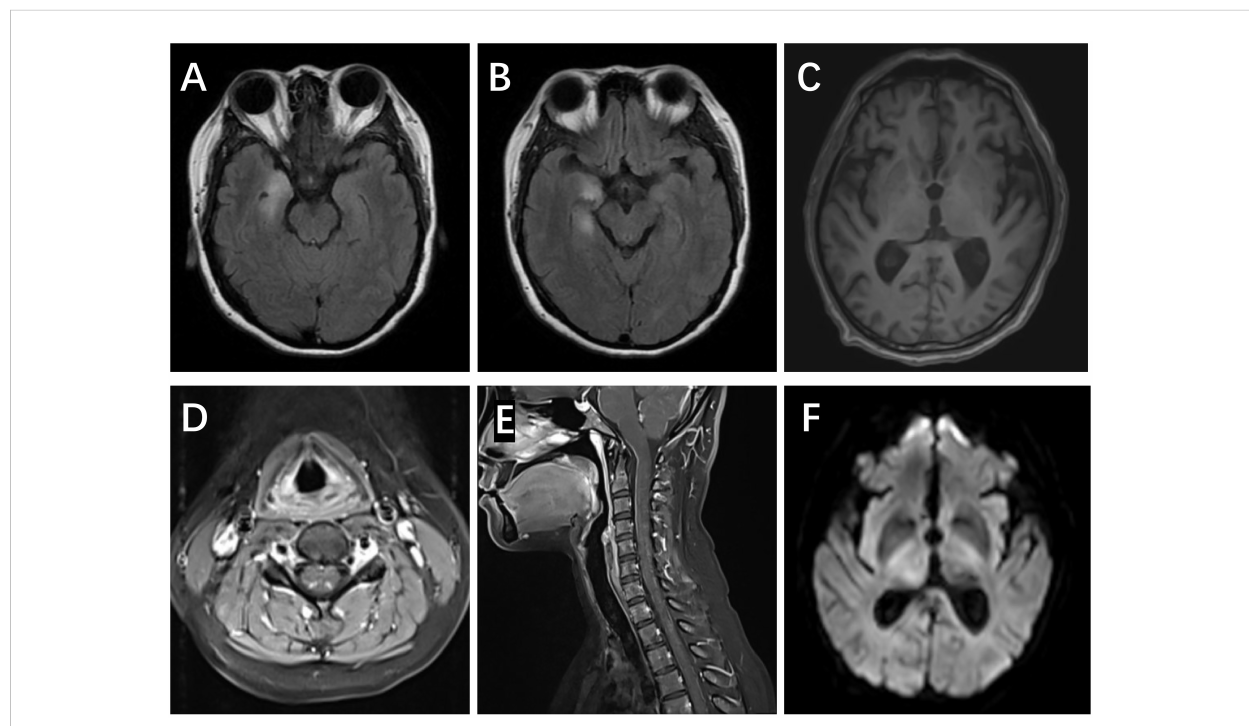
FIGURE 1 MRI scans in anti-amphiphysin encephalitis. (A, B) Right FLAIR hyperintensities in the medial temporal lobes, including both the amygdala and hippocampus (Patient #1). (C) The blurred structure of the bilateral thalamus (Patient #4). (D, E) Increased T2 signal and enhancement in posterior horn of the spinal cord (C2-7) (Patient #9). (F) Restriction of DWI in the right thalamus (Patient